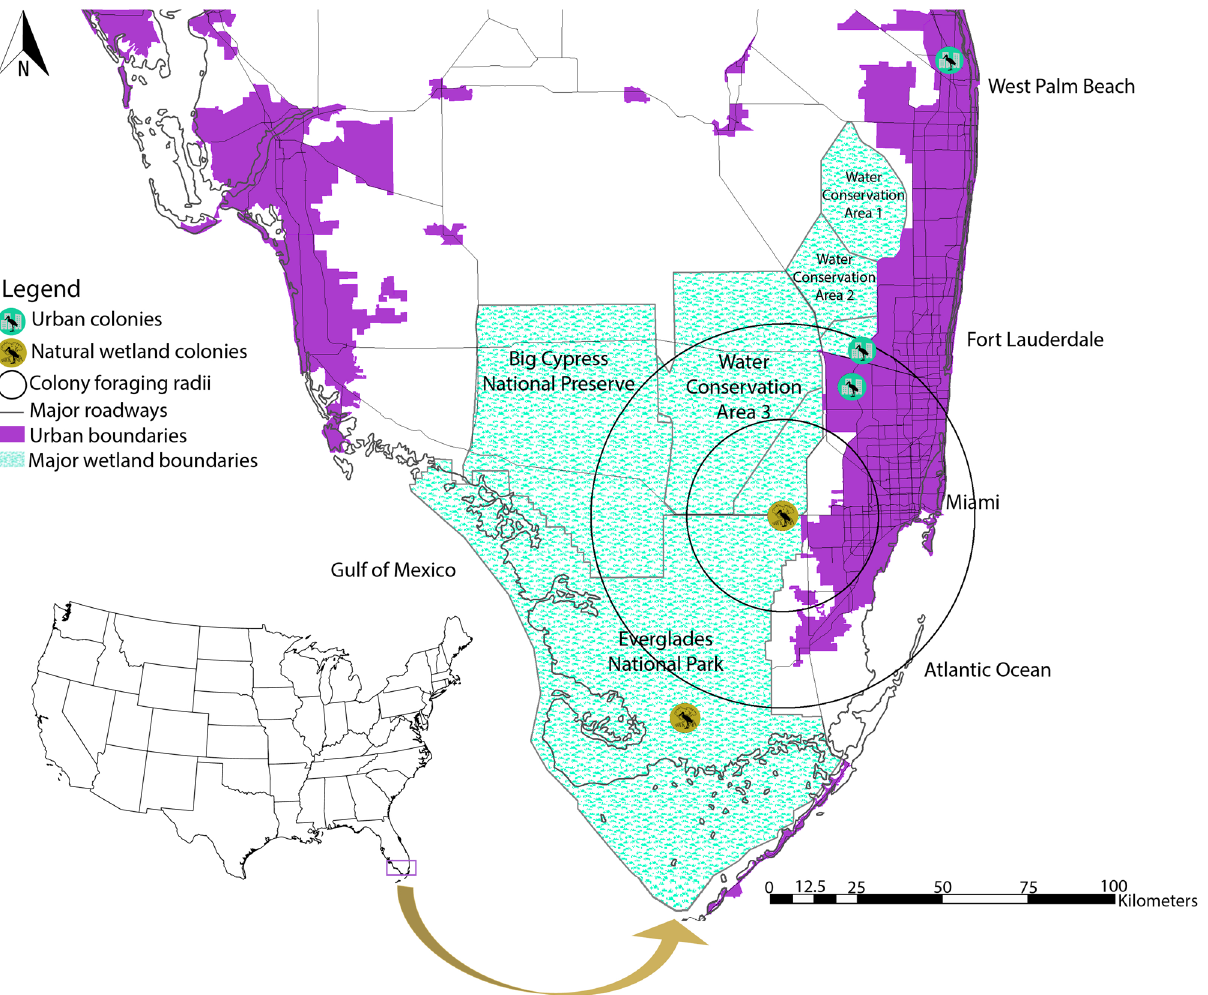
Figure 5. Location of stork nesting colonies (n = 5) in South Florida, 2015–2017. Colony foraging radii represents the typical minimum (25 km) and maximum (50 km) stork foraging distances 100 . Locations of